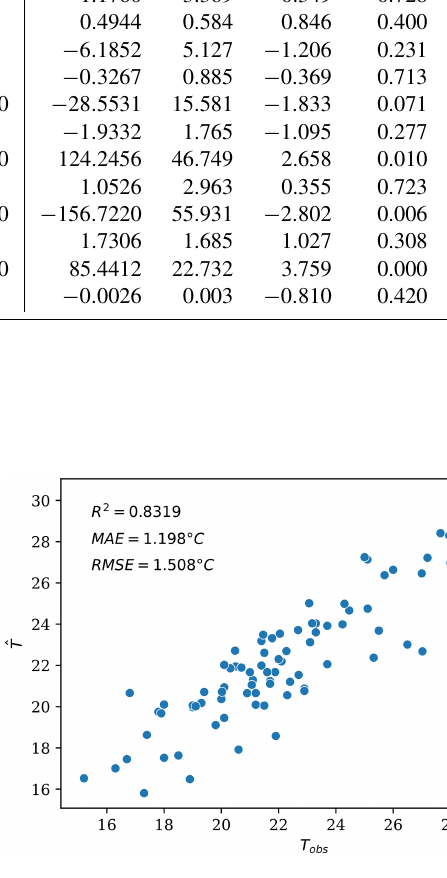
Figure B1. Scatterplot of the T air predicted by the linear regression model trained with all of the samples ( y axis) versus the observed measurements ( x